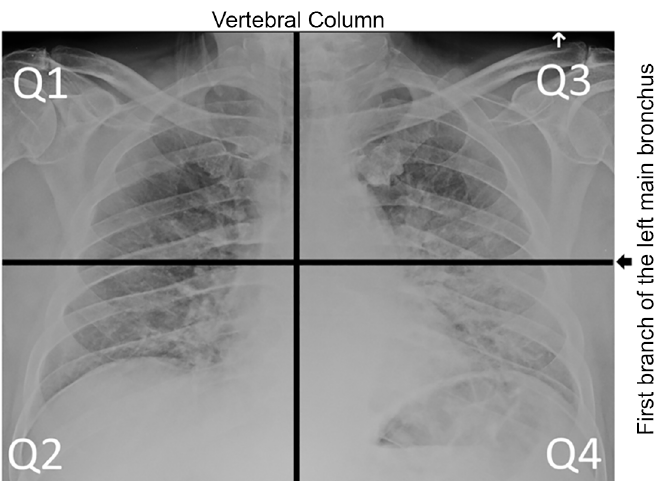
Figure 2. An example of radiograph assessment of lung edema (RALE) scoring in a 71-year-old man with COVID-19 who presented 5 days after symptom onset, with fever, cough and fatigue. RALE scoring: reader 1: 11, reader 2: 12. Adapted from Warren et al, 2018.